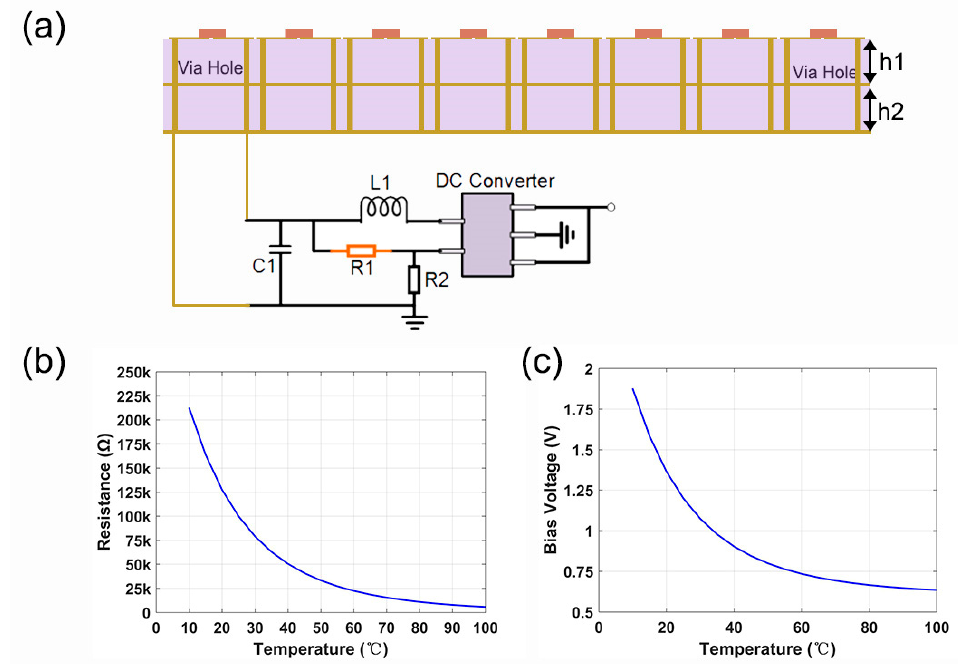
Figure 3. The design diagram of microcircuit, and a graphic of resistance value and bias voltage changing with temperature. ( a ) Specific voltage control module diagram; ( b , c ) show the schematic diagram of the change in thermistor and bias voltage with temperature.